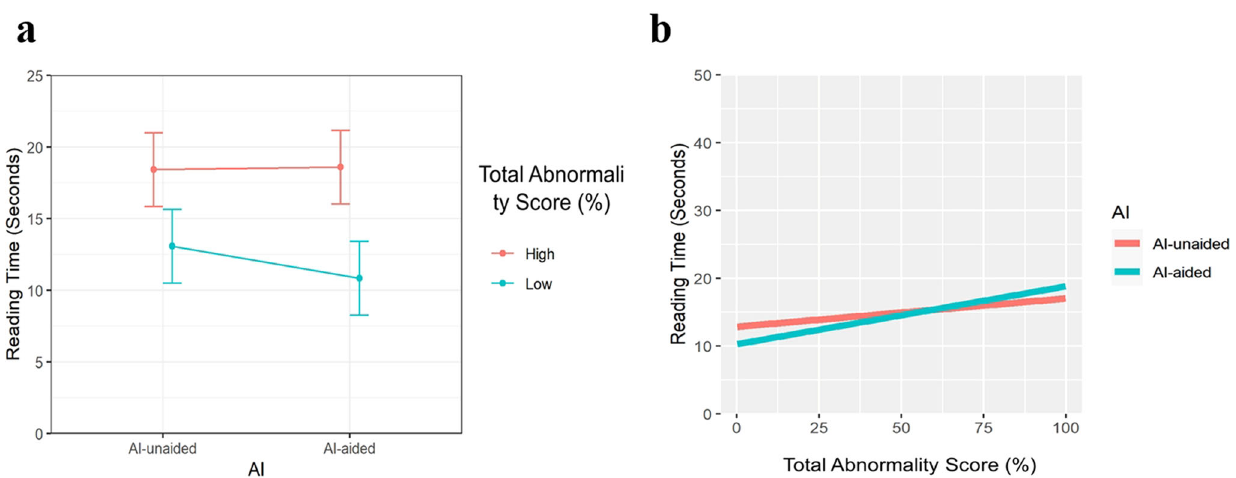
Fig. 2 Reading time in AI-unaided and aided conditions. a According to the presence or absence of a lesion on chest radiographs (total abnormality scores — high: ≥ 15% representing the presence of any lesion, low: <15% representing the absence of any lesion by AI) and b according to the total abnormality scores (0 –